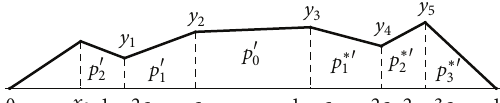
Figure 13: Illustration for Proposition